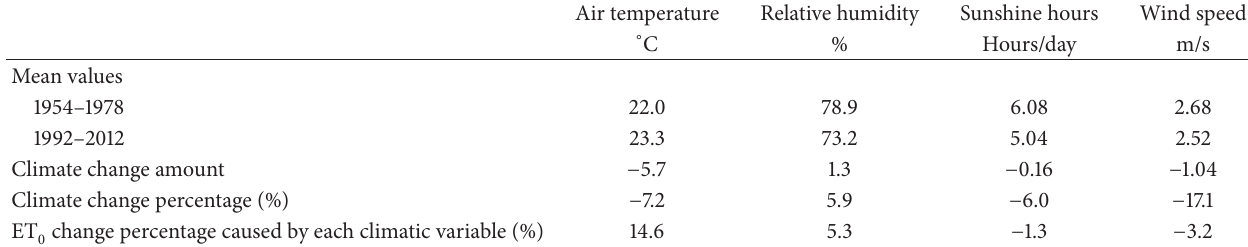
Table 1: Mean values of each climatic variable in the periods of 1954–1978 and 1992–2012 and changes of each climatic variable to ET variation.